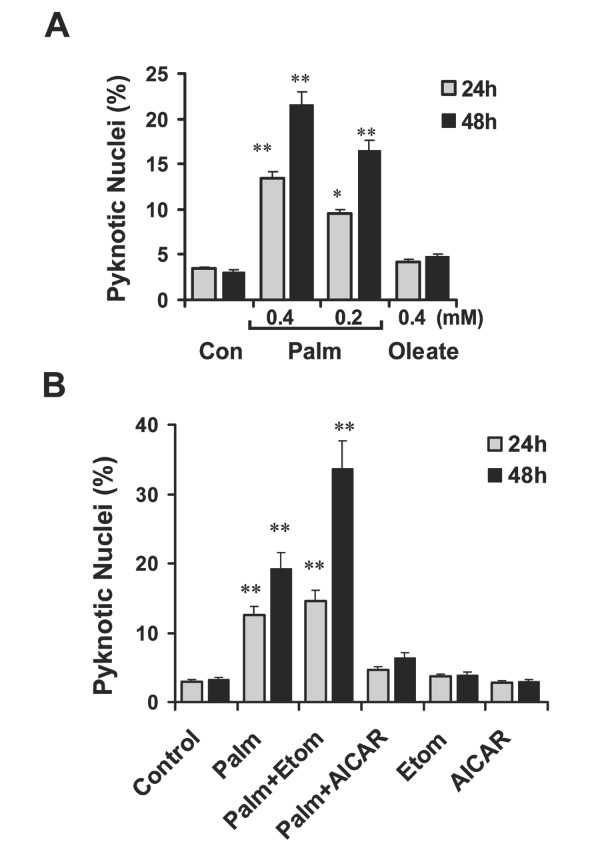
Palmitate-induced formation of pyknotic nuclei and the role of mitochondrial β-oxidation. (A) HMC were treated with palmitate (Palm) or oleate as described in Fig. 1, and the number of pyknotic nuclei were counted after 24 and 48 h in the presence of FFA. (B) HMC incubated with 0.2 mM palmitate in the presence and absence of 0.2 mM etomoxir (Etom) or 0.5 mM AICAR. Cells were also incubated with the same doses of etomoxir or AICAR alone. Data are mean ± SEM for n = 3 independent experiments in duplicate. **, P < 0.01 versus control (Con) or oleate alone (A) by Chi-square test.